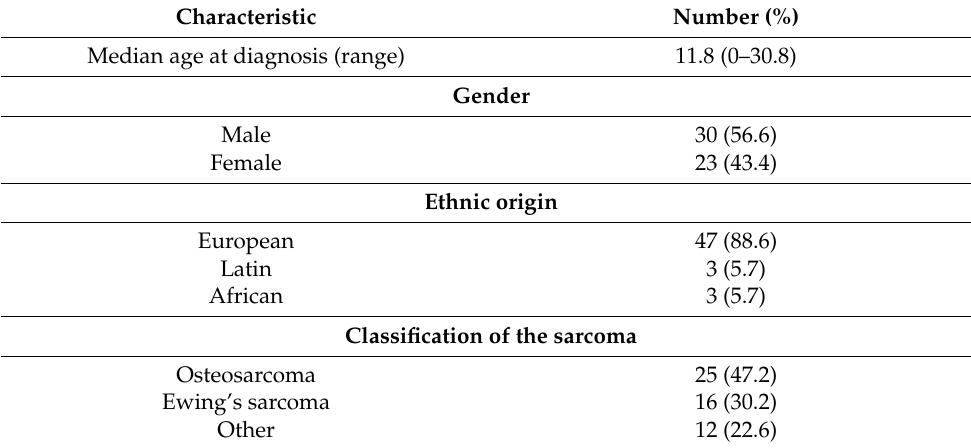
Table 1. Clinical characteristics of 53 patients with